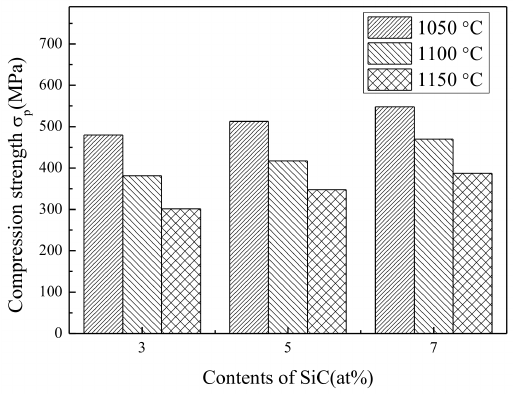
Figure 10. Compressive strength and peak stress at different